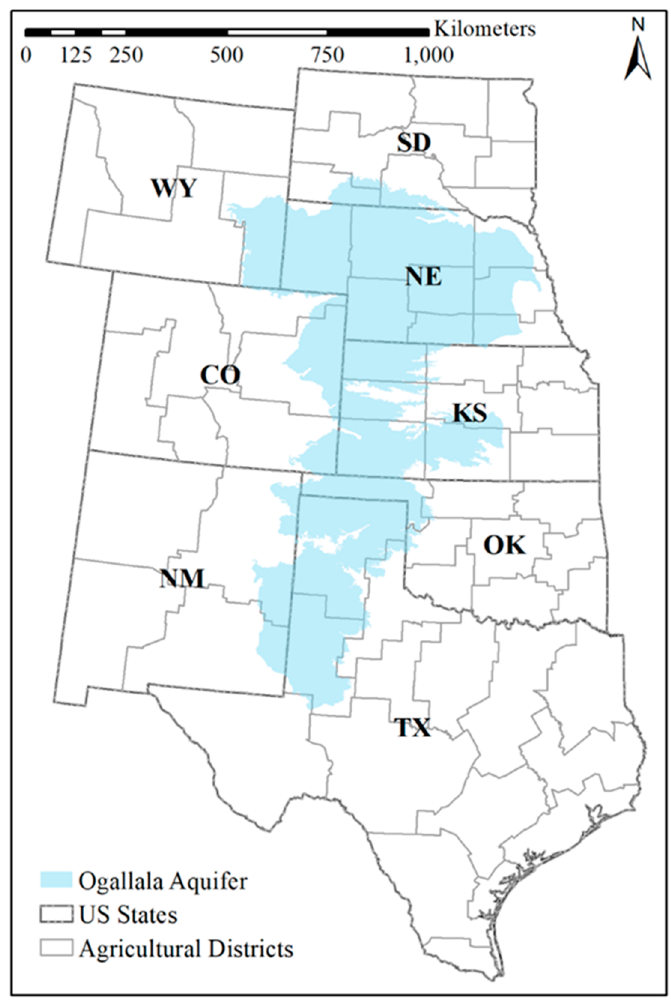
Figure 1. Map of study area [23].